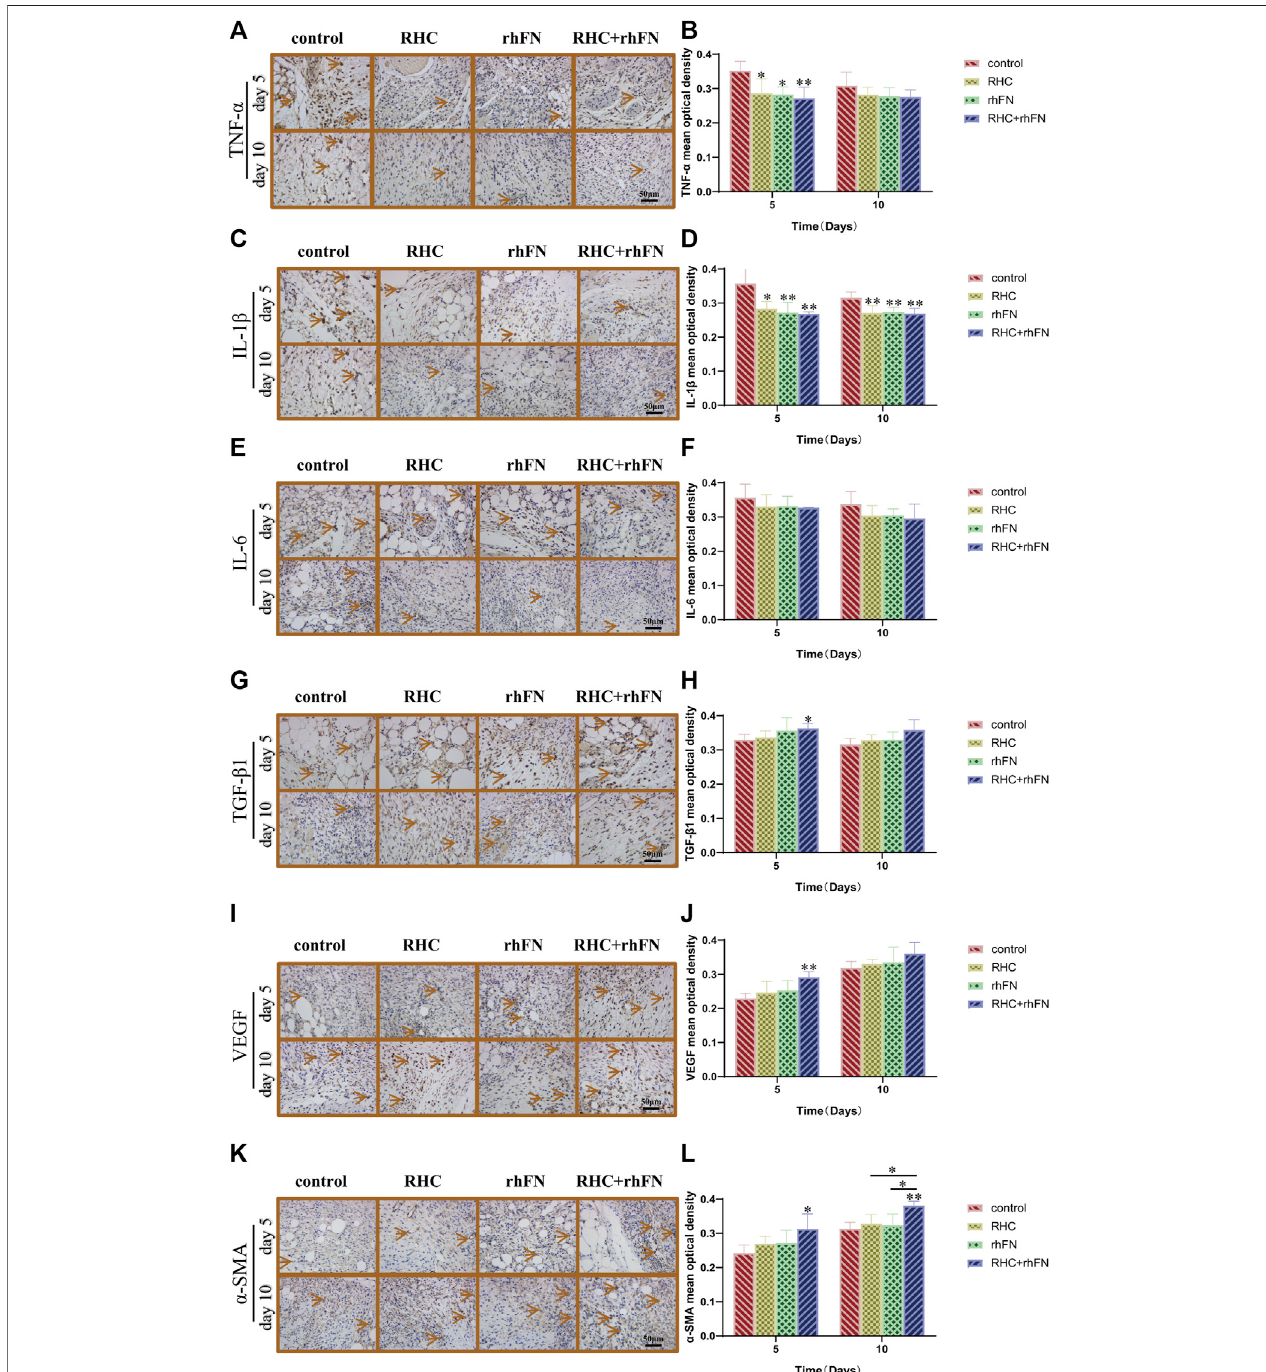
FIGURE 8 | The analysis of immunohistochemistry. (A) Representative images of TNF- α on PID 5 and 10. Scale bar = 50 μ m. (B) Calculation and comparison of TNF- α on PID 5 and 10. Data are presented as the mean ± SD ( n = 5). Statistical analysis: p p < 0.05, pp p < 0.01. (C) Representative images of IL -1 β on PID 5 and 10. Scalebar=50 μ m. (D) CalculationandcomparisonofIL-1 β onPID5and10.Dataarepresentedasthemean±SD( n =5).Statisticalanalysis: p p < 0.05, pp p < 0.01. (E) RepresentativeimagesofIL-6onPID5and10.Scalebar=50 μ m. (F) Calculationandcomparison ofIL-6onPID5and10.Dataarepresented asthemean±SD ( n =5).Statisticalanalysis:ns p > 0.05 (G) RepresentativeimagesofTGF- β 1onPID5and10.Scalebar=50 μ m (H) CalculationandcomparisonofTGF- β 1onPID5and 10.Dataarepresentedasthemean±SD( n =5).Statisticalanalysis: p p < 0.05 (I) RepresentativeimagesofVEGFonPID5and10.Scalebar=50 μ m (J) Calculationand comparisonofVEGFonPID5and10.Dataarepresentedasthemean±SD( n =5).Statisticalanalysis: pp p < 0.01 (K) Representativeimagesof α -SMAonPID5and10. Scale bar = 50 μ m (L) Calculation and comparison of α -SMA on PID 5 and 10. Data are presented as the mean ± SD ( n = 5). Statistical analysis: p p < 0.05, pp p < 0.01.